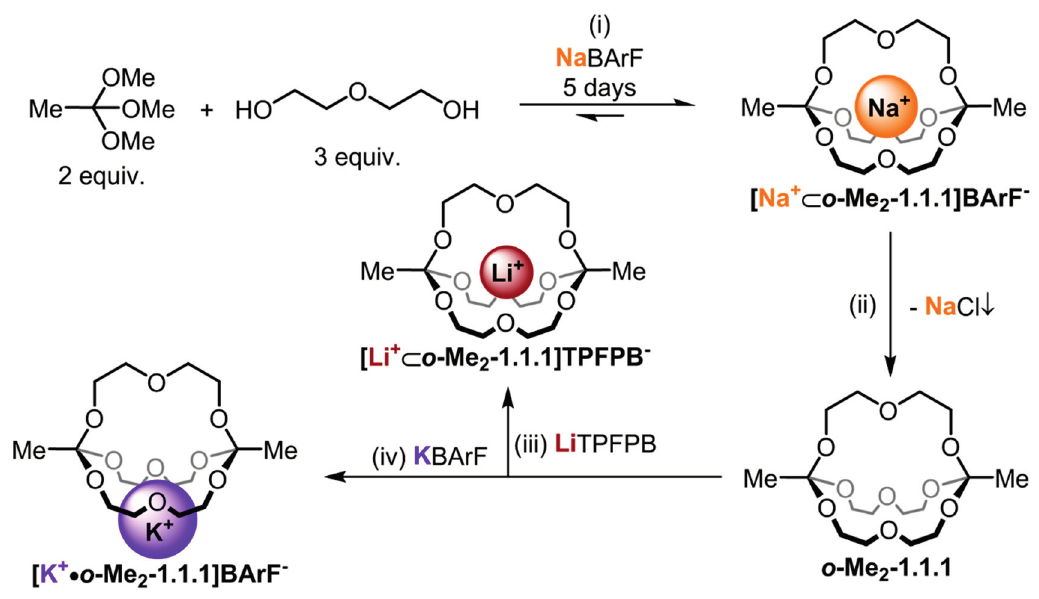
Figure 1. Synthesis route for the different alkali metal complexes. ( i ) 5% TFA, MS 4 Å, CDCl 3 (10 mM in respect to NaBArF (sodium tetrakis[3,5-bis(trifluoromethyl)phenyl]borate)), RT; ( ii ) Lewatit ® MP-64 anion exchange resin, CDCl 3 , 6h, RT; ( iii ) 1.0 equiv. LiTPFPB (lithium tetrakis(pentafluorophenyl) borate ethyl etherate), CDCl 3 , RT; ( iv ) 1.0 equiv. KBArF (potassium tetrakis[3,5-bis(trifluoromethyl)phenyl]borate), CDCl 3 ,